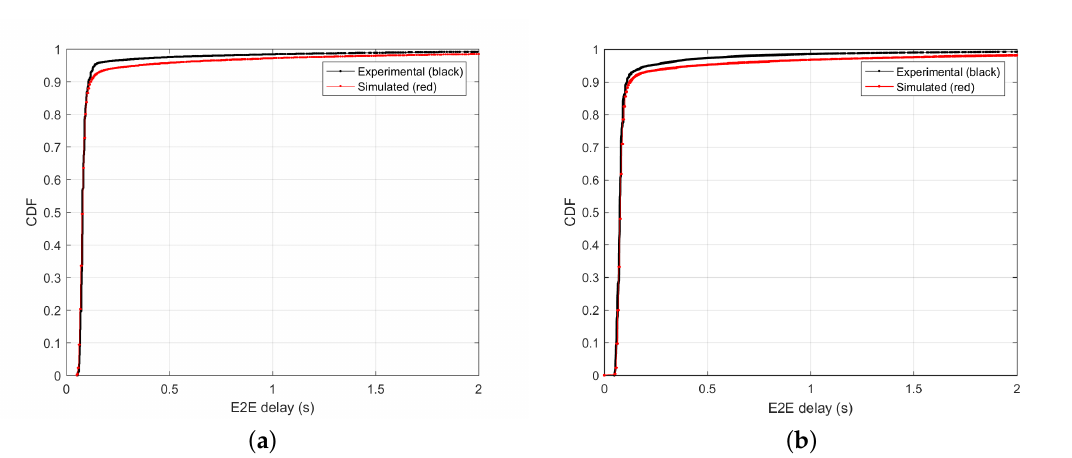
Figure 13. Comparison of E2E delay CDF generated from the model after collecting E2E delays of each generated samples: Expanded time scale up to 2 s, two different experimental samples of the same railway section (WCDMA 2100 technology